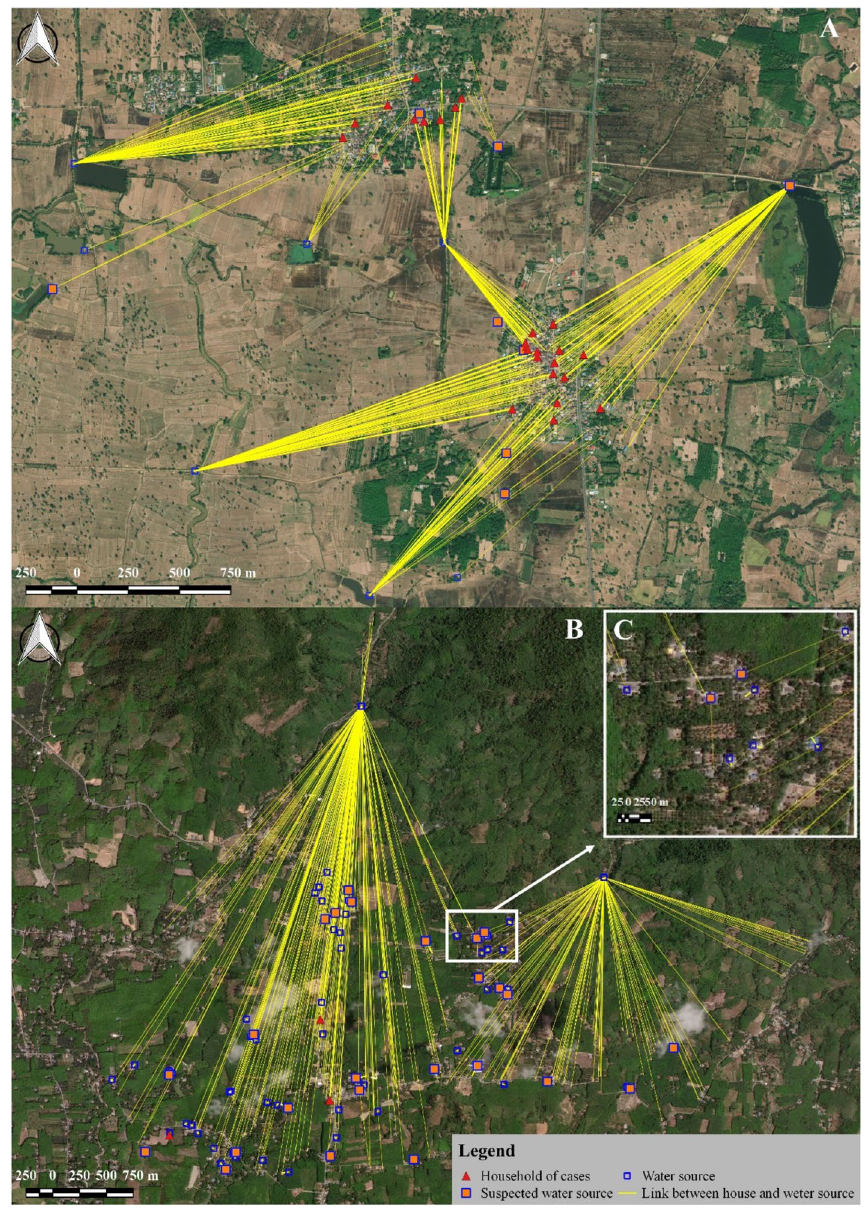
Figure 1. Surveyed households (n = 746) and water sources (n = 90) in ( A ) Hua Suea sub-district, Khukhan, Sisaket and ( B ) Na Luang Sen sub-district, Thung Song, Nakhon Si Thammarat. The location markers represent water sources. ( C ) A groundwater source owned by a household was usually close to or within the house. Quantum GIS version 3.12 (ESRI satellite) was used to map surveyed households and water sources (https ://